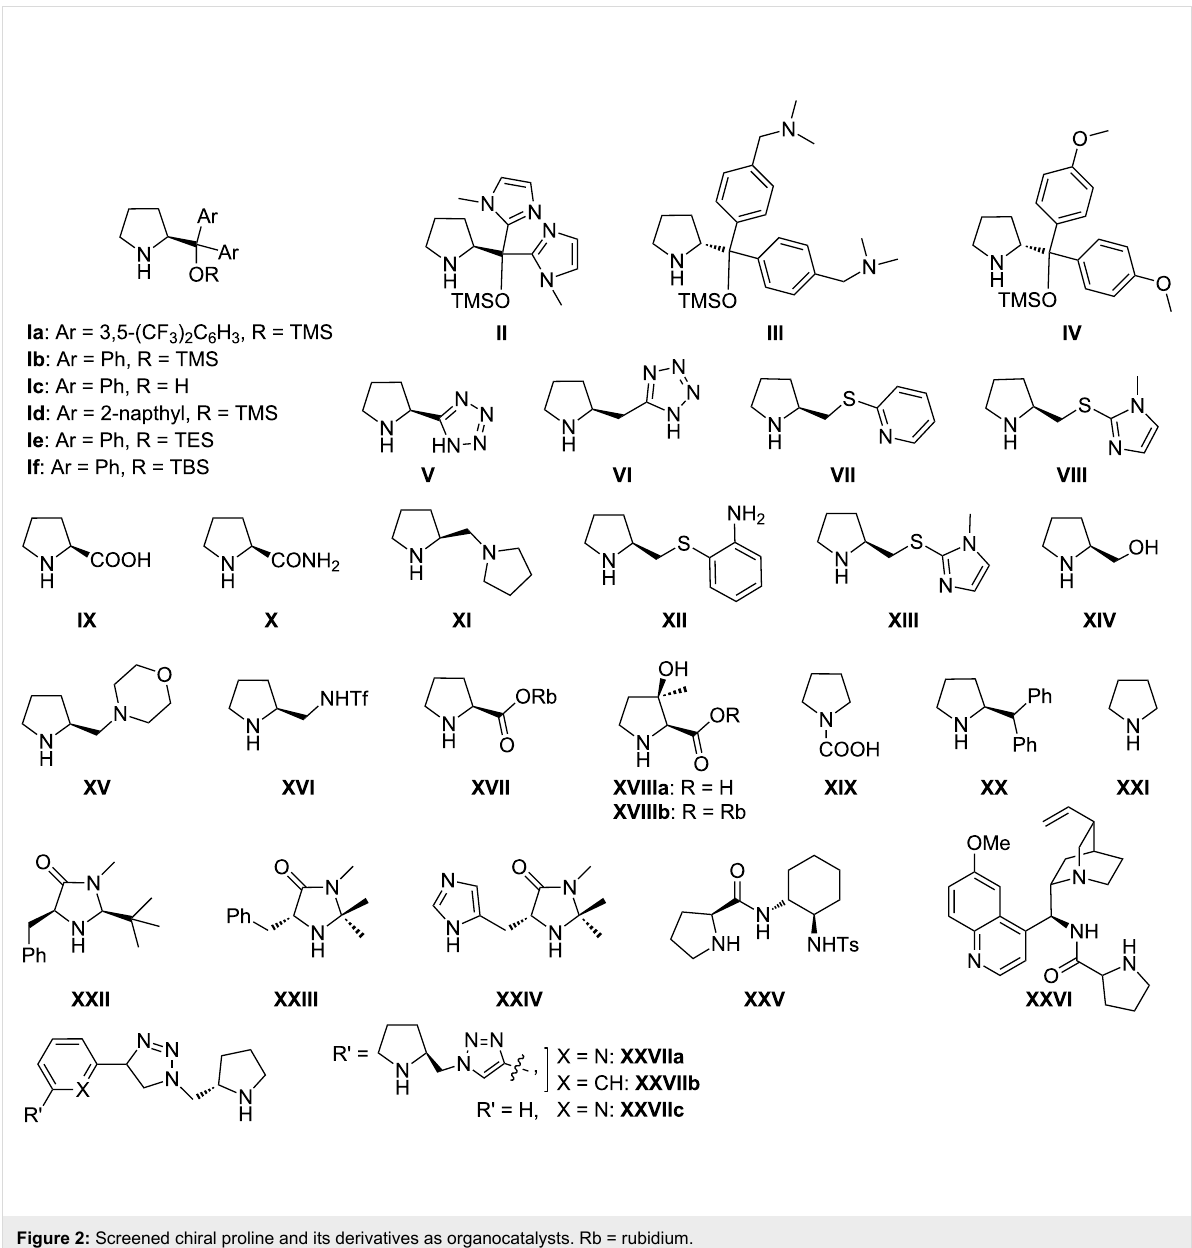
Figure 2: Screened chiral proline and its derivatives as organocatalysts. Rb = rubidium.